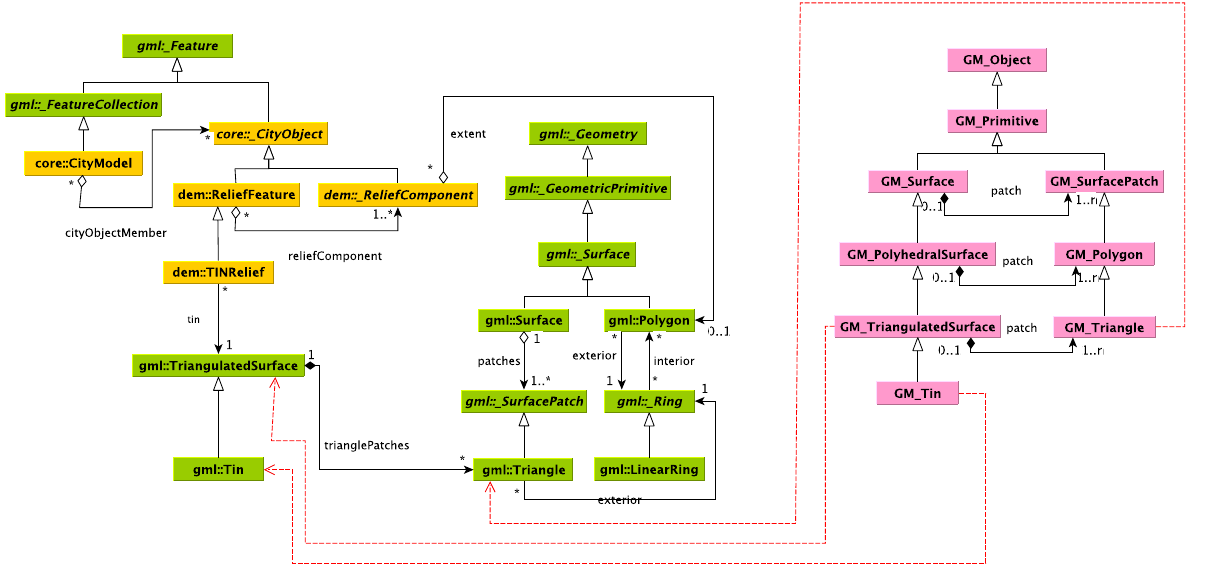
Figure 6: TINs in CityGML and ISO 19107:2003 Spatial schema